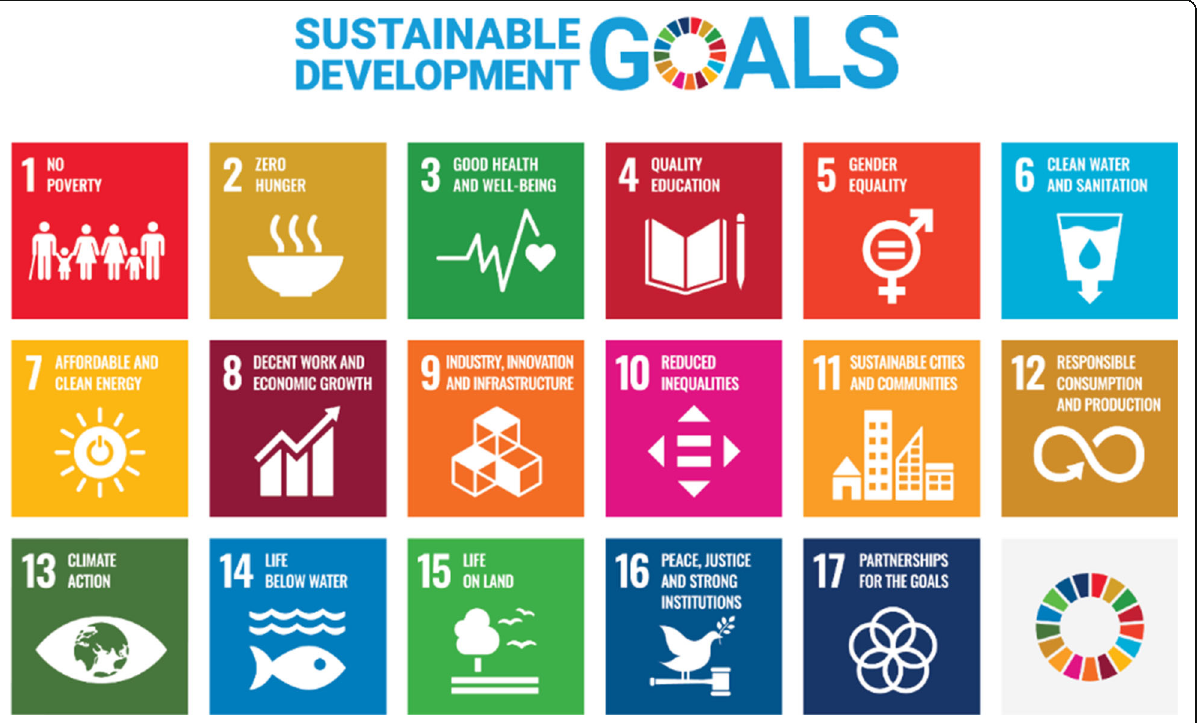
Fig. 1 The Sustainable Development